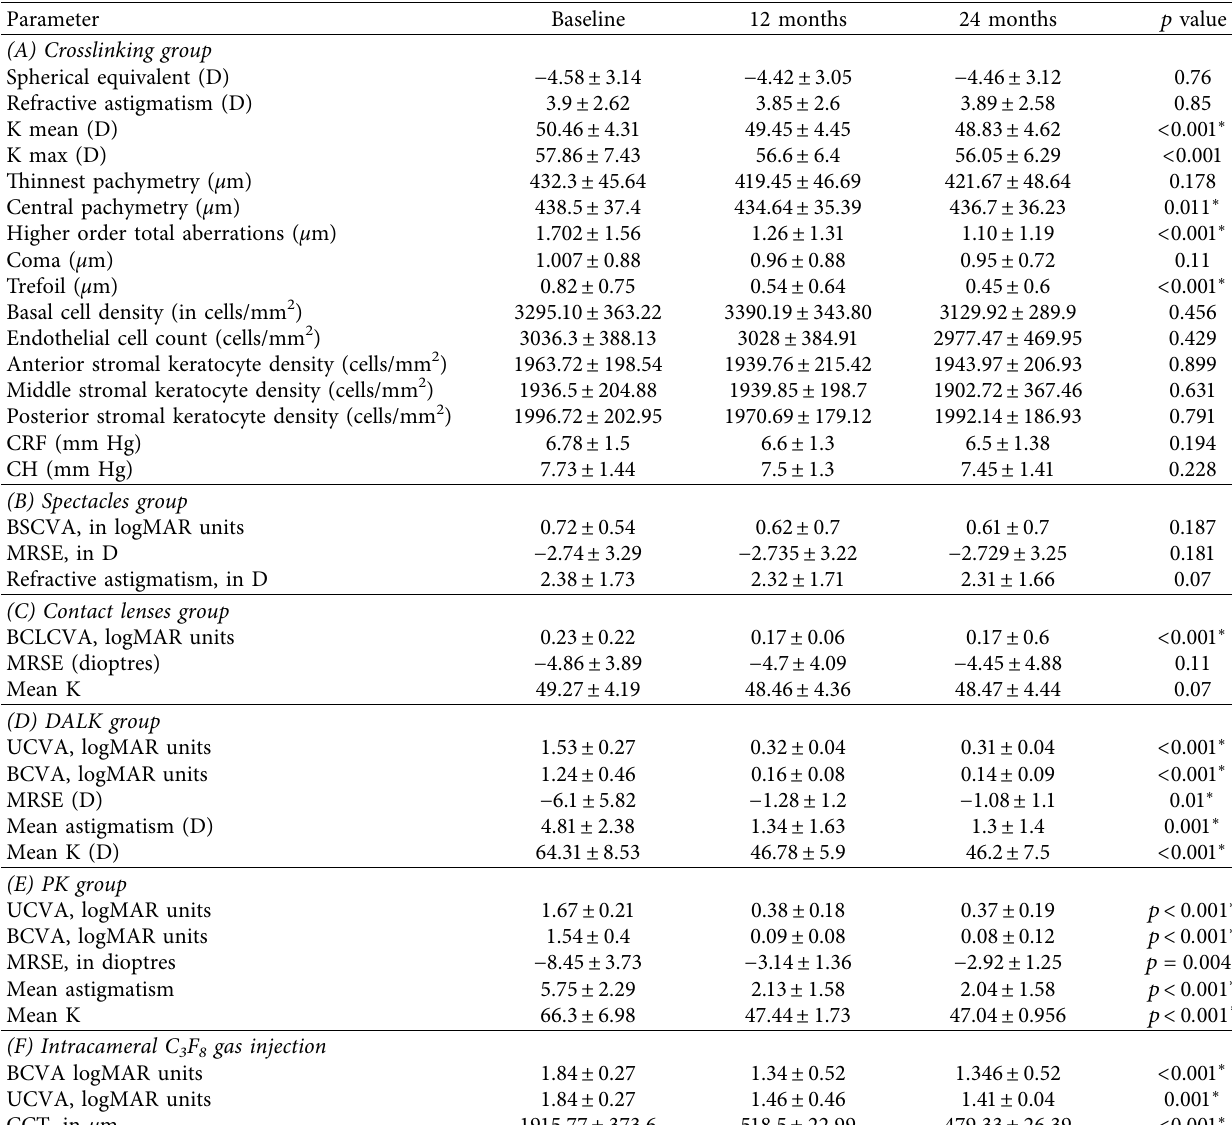
Figure 1: Management flowchart of cases of KC ( ∗ DALK was planned in 12 eyes, but performed in 11 eyes as 1 eye had conversion to PKP due to intraoperative perforation of Descement’s membrane; KC: keratoconus, CXL: corneal collagen cross linking, DALK: deep anterior lamellar keratoplasty, PKP: penetrating keratoplasty, and C3F8: Table 1: Treatment outcomes of pediatric keratoconus with different management modalities using global consensus guidelines.